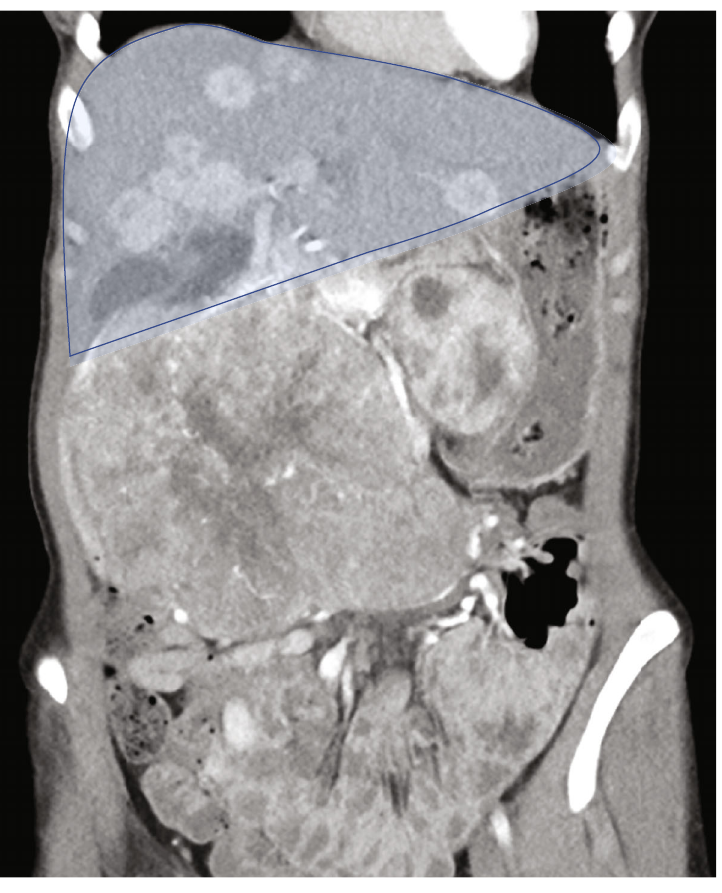
Figure 2: Metastatic liver.